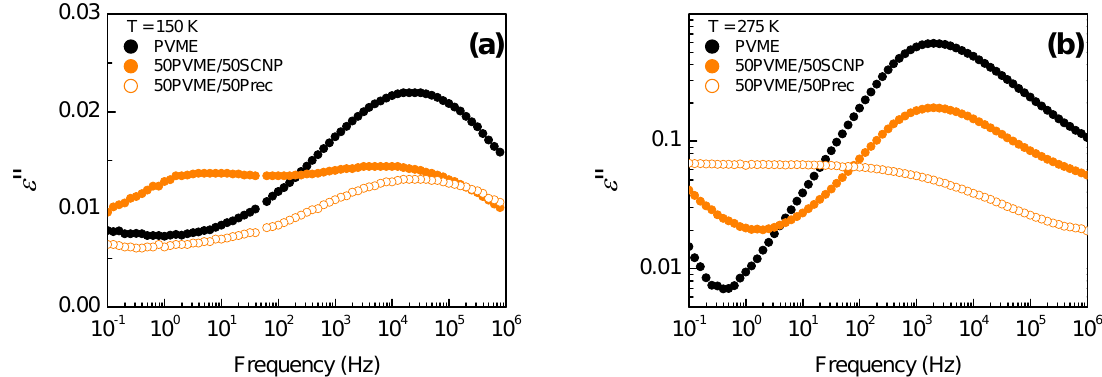
Figure 2. Dielectric loss curves for PVME (black symbols), the 50% mixtures with the SCNPs (full symbols), and the precursor (empty symbols), at a temperature ( a ) below and ( b ) above T g